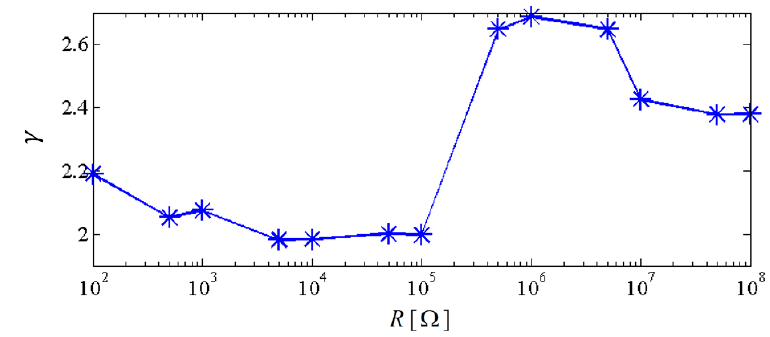
Figure 9. Output power area ratio of the NPEHS-1 versus load resistance.